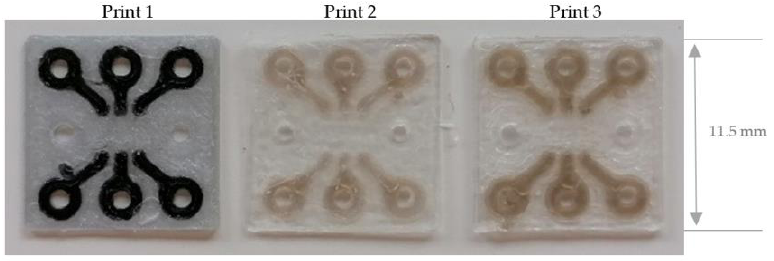
Figure 16. 3D printed single-layer RGB sequins with different print cores and various 3D printing Figure 16. 3Dprintedsingle-layerRGBsequinswithdifferentprintcoresandvarious3Dprintingmaterials. materials.